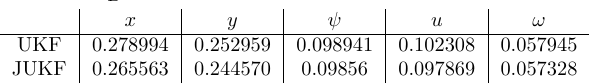
Table 4: RMS errors of the simulation Test 4, τ C = 5 s , τ D = 4 s